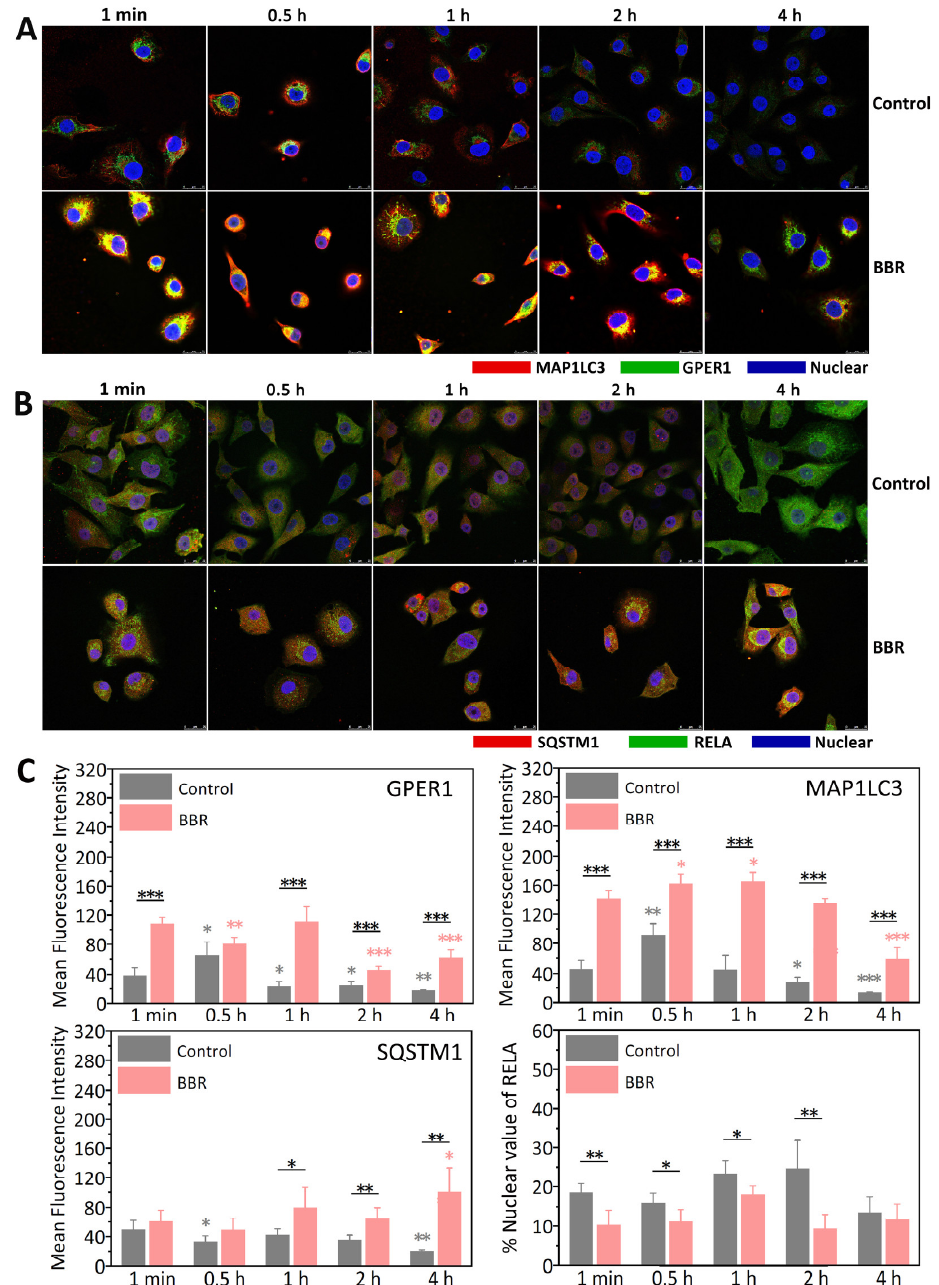
Figure 5. BBR induced a high degree of co-localization of GPER1 and MAP1LC3. MDA-MB-231 cells were treated with 0.1% DMSO and 50 μM BBR for different lengths of time. ( A ) The nucleus, GPER1, and MAP1LC3 were marked with different fluorescent dyes. ( B ) The nucleus, RELA, and SQSTM1 were marked with different fluorescent dyes. ( C ) Mean fluorescence intensity of the proteins (GPER1, MAP1LC3, SQSTM1) and the % nuclear value of RELA were calculated by fluorescence-based quantification, n = 4. p < 0.05 (*), p < 0.01 (**), p < 0.001 (***).